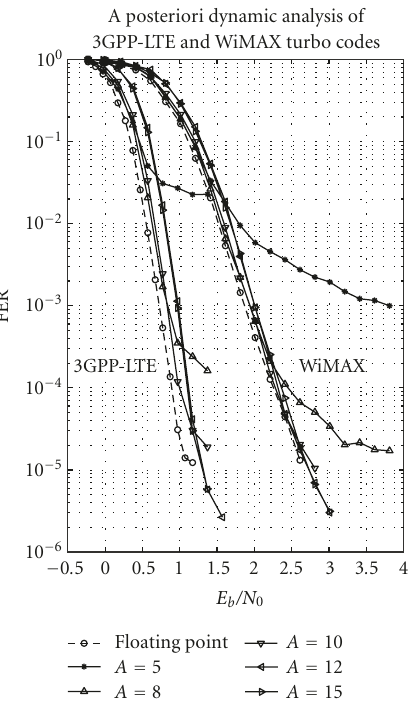
Figure 14: End-to-end fixed-point performance for di ff erent values of A . λ ch